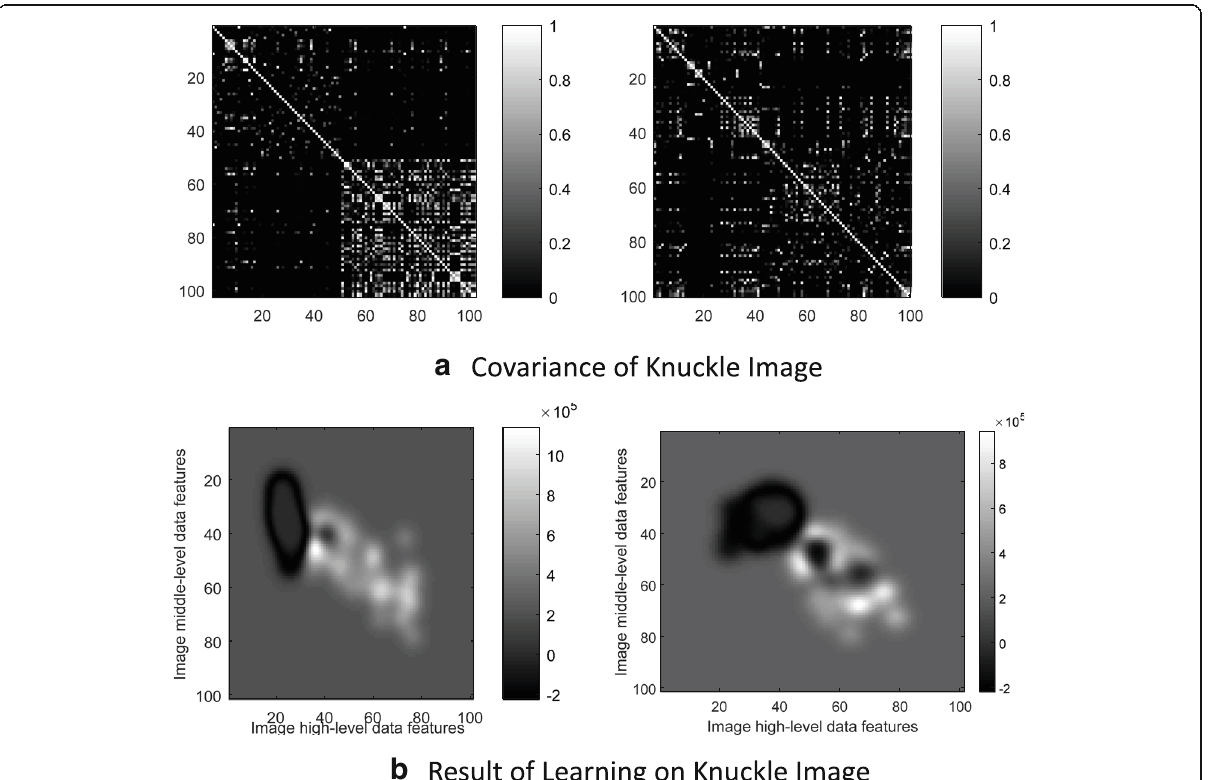
Fig. 8 Synthesis learning of multilayer data from knuckle image. a Covariance of knuckle image. b Result of learning on knuckle